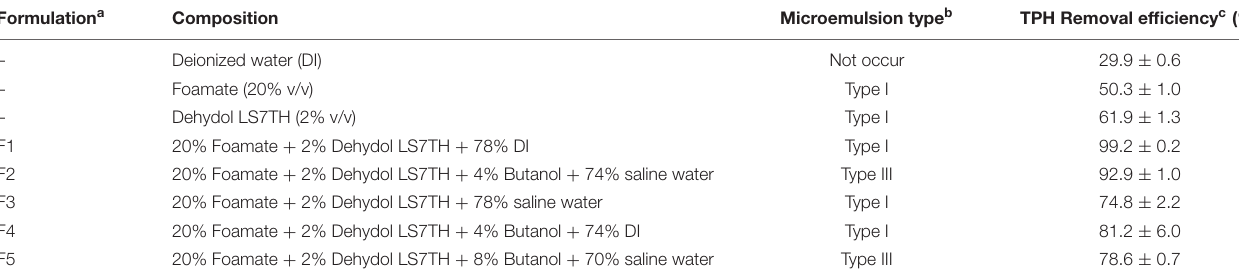
FIGURE 2 | Microemulsion phase behavior of polyolefin and surfactant solution containing 2% Dehydol LS7TH, 4% butanol and varying volumes of foamate in saline water. The petroleum hydrocarbon removal efficiency of each formulation was conducted with drill cutting in a batch experiment. The ratio of cutting (g) to washing agent (mL) was 1:2 and the washing time was 30 min. TABLE 2 | Effectiveness of bio-based washing agents on removal of petroleum hydrocarbons from drill cuttings in a batch experiment. Formulation